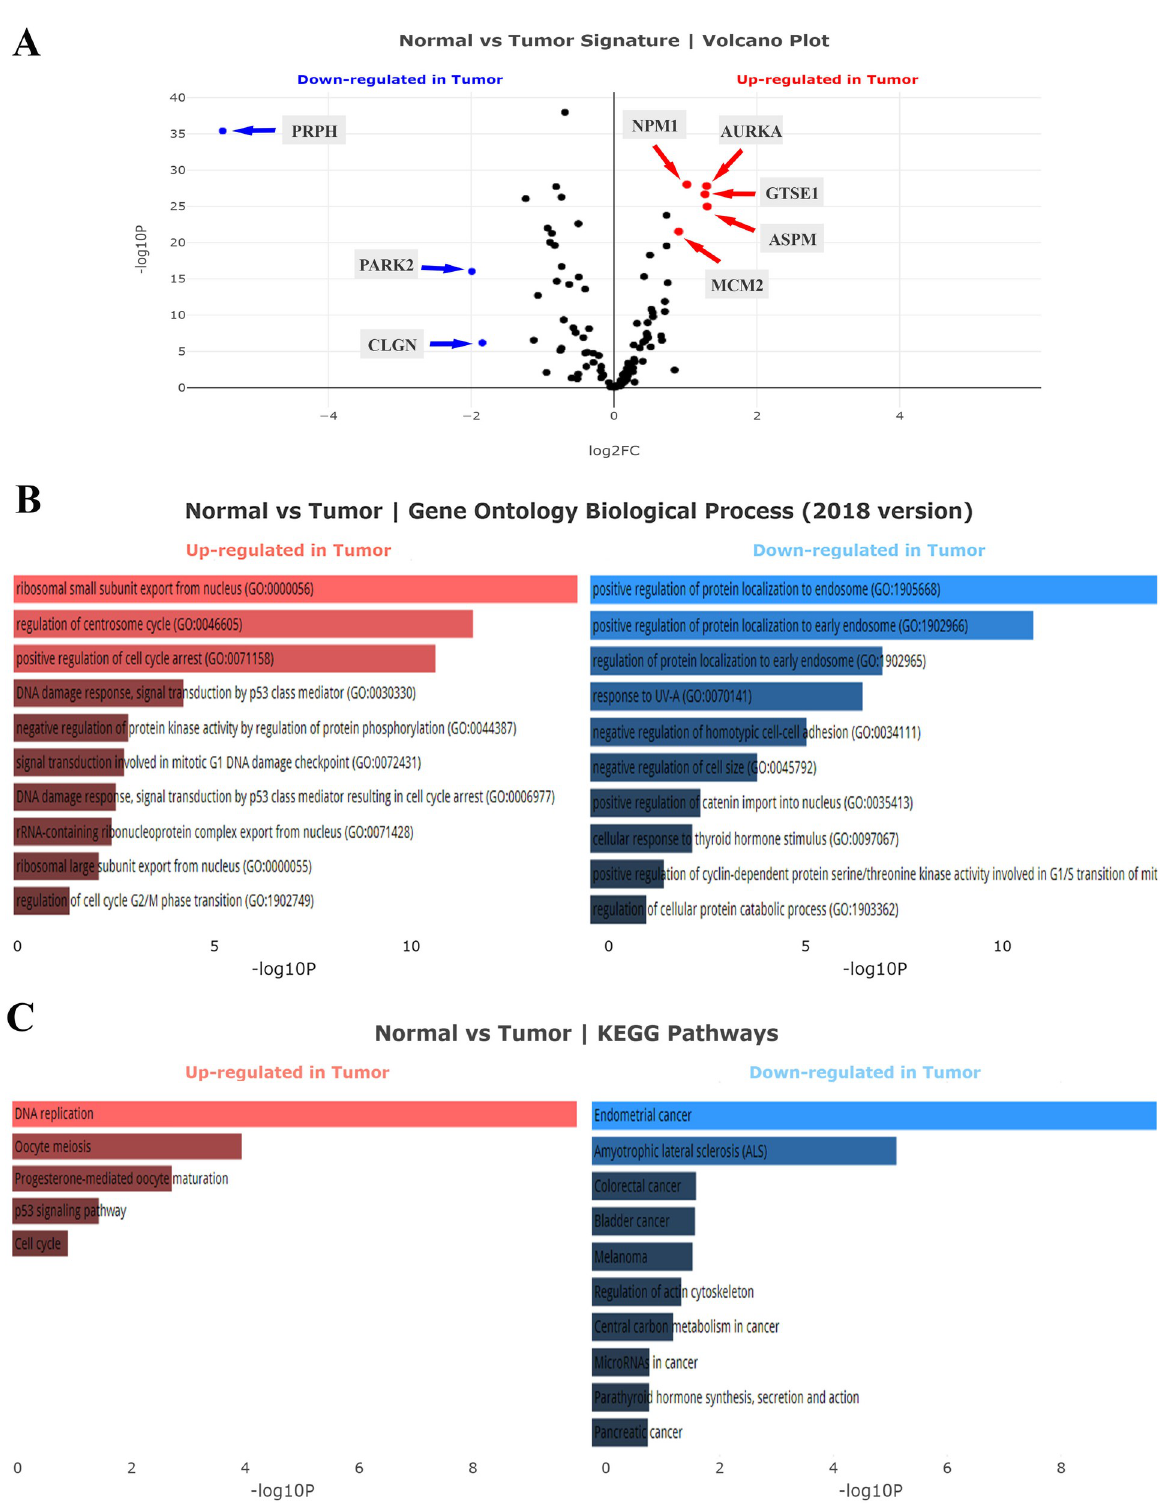
Fig 2. Analysis of calumenin correlated genes in TCGA-COAD. (A) Volcano plot analysis of the TCGA-COAD dataset. (B) Gene Ontology (GO) biological process analysis. (C) KEGG pathways analysis. The statistical significance of each gene was calculated using the Cuffdiff package and demonstrated as log2-fold changes in the volcano plot. Red points mean significantly upregulated genes, and blue points mean downregulated genes.